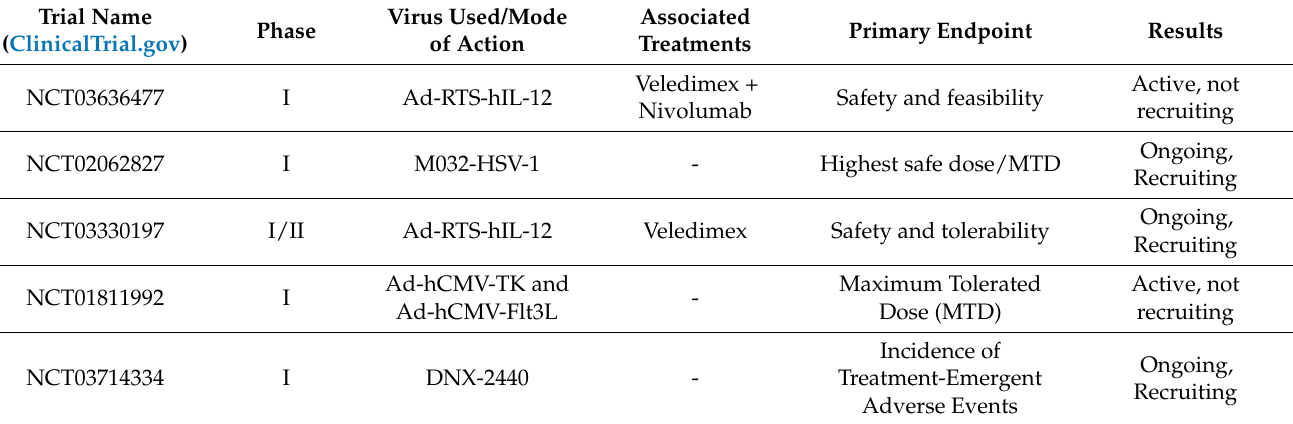
Table 2. Clinical trials on the effectiveness of modified oncolytic viruses against